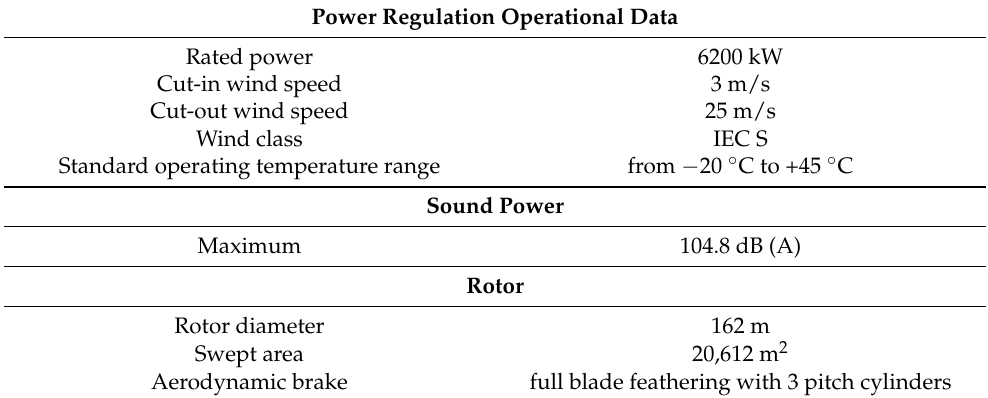
Table 2. Eventus TM platform V162-6.2 MW TM [52].